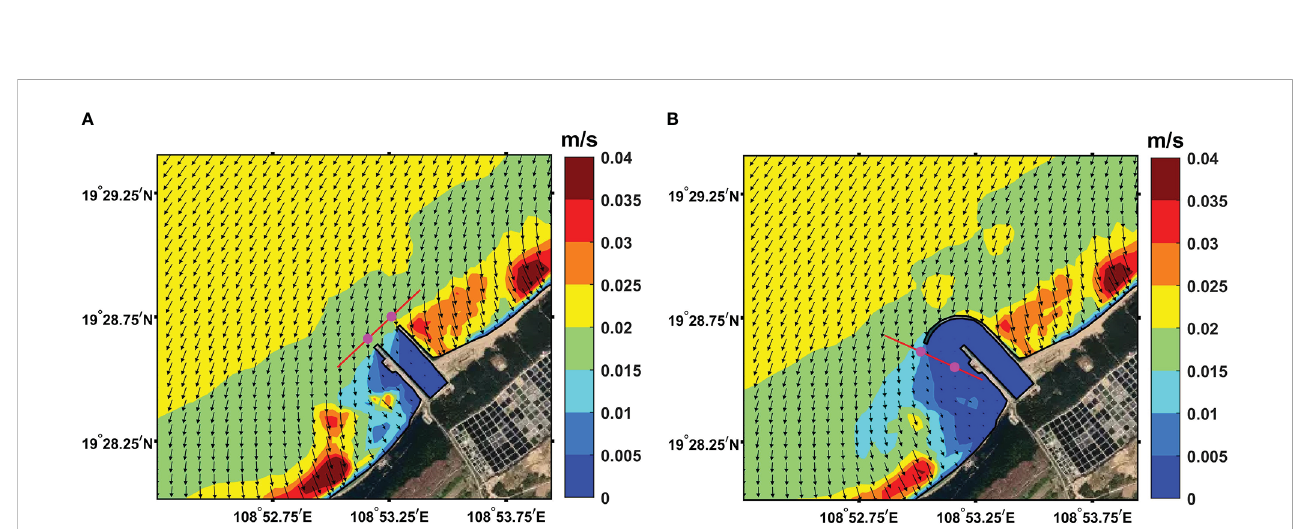
FIGURE 7 The position of current – velocity pro fi le section (red line) for two model cases: (A) C1, with an offshore inlet mouth, and (B) C2, with a downstream inlet mouth. The two magenta dots in the red line mark the section fragment closest to the inlet mouth. The black vectors indicate the mean surface Stokes drift on 2 April 2019, with color shading representing the vector